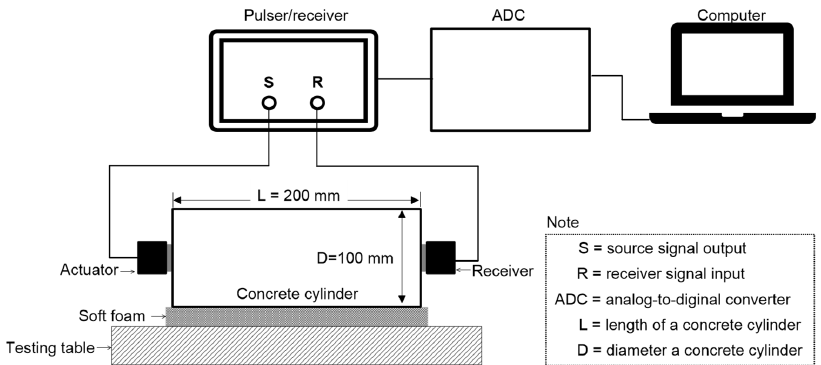
Figure 2. Test setup for ultrasonic pulse velocity measurements.